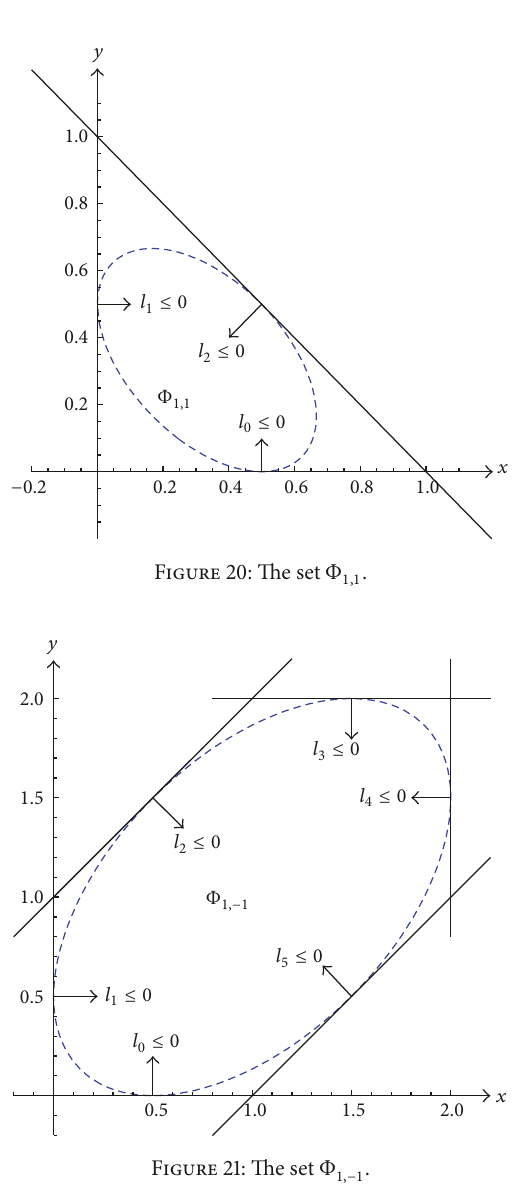
Figure 21: The set Φ 1,−1